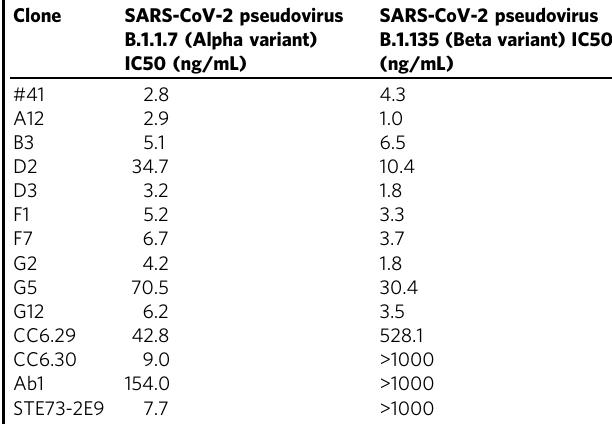
Table 3 Neutralization potencies of the selected antibodies obtained against the Alpha and Beta variants.